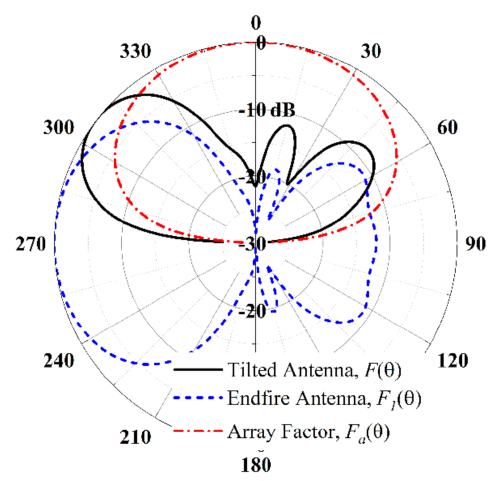
Figure 12. Theory of tilted-beam formation ( f = 5.7 GHz, h g = 8 mm).